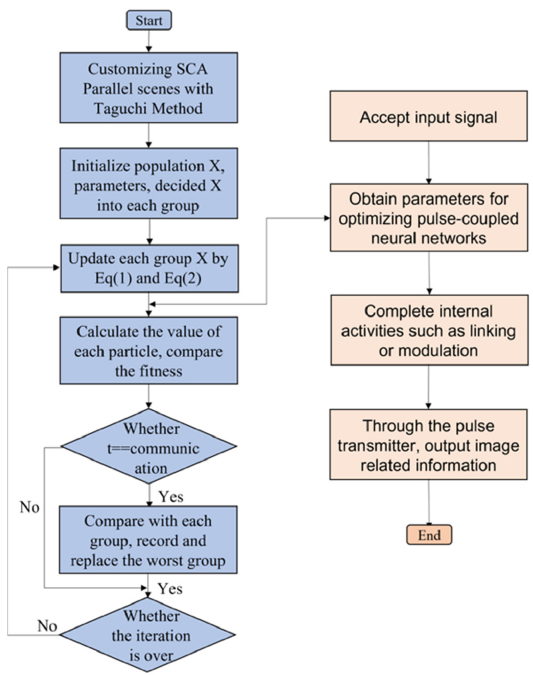
Figure 6. Flowchart of TPSCA–PCNN.